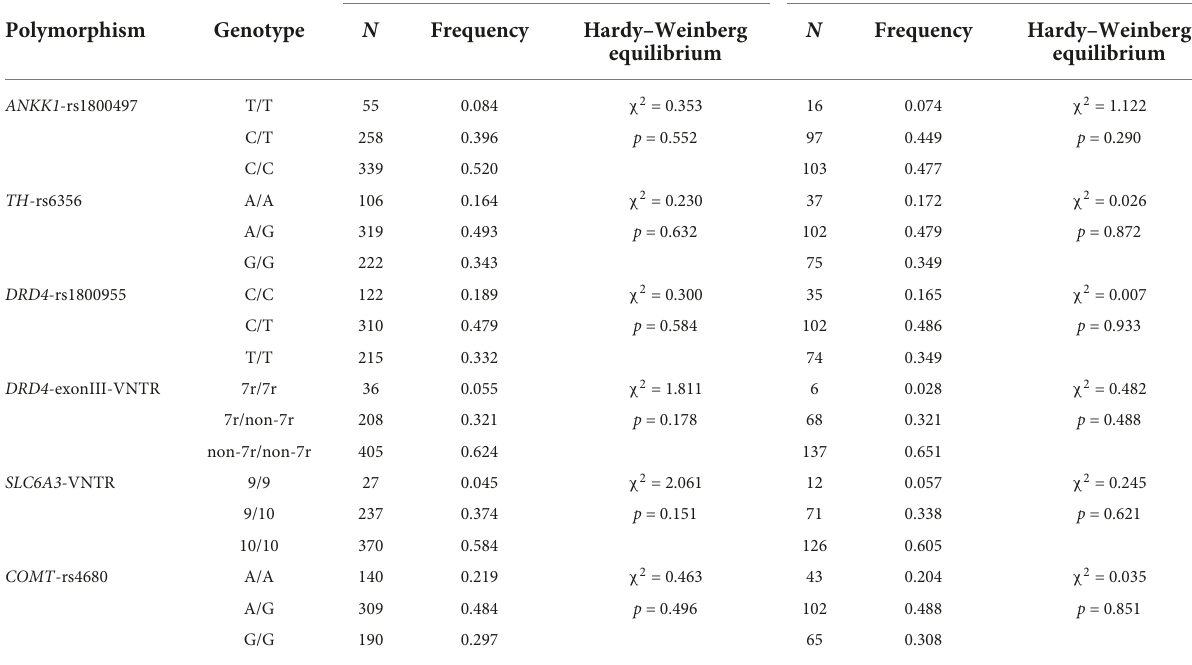
TABLE 1 Genotype frequencies and Hardy–Weinberg equilibrium ( χ 2